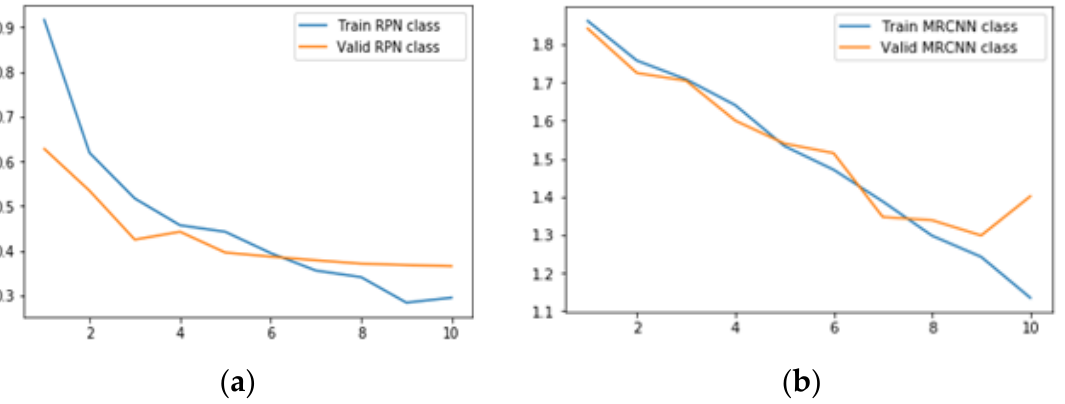
Figure 16. Class loss for the proposed model with LR = 0.0006, epochs = 10, ( a ) RPN class loss; ( b ) MRCNN class loss.